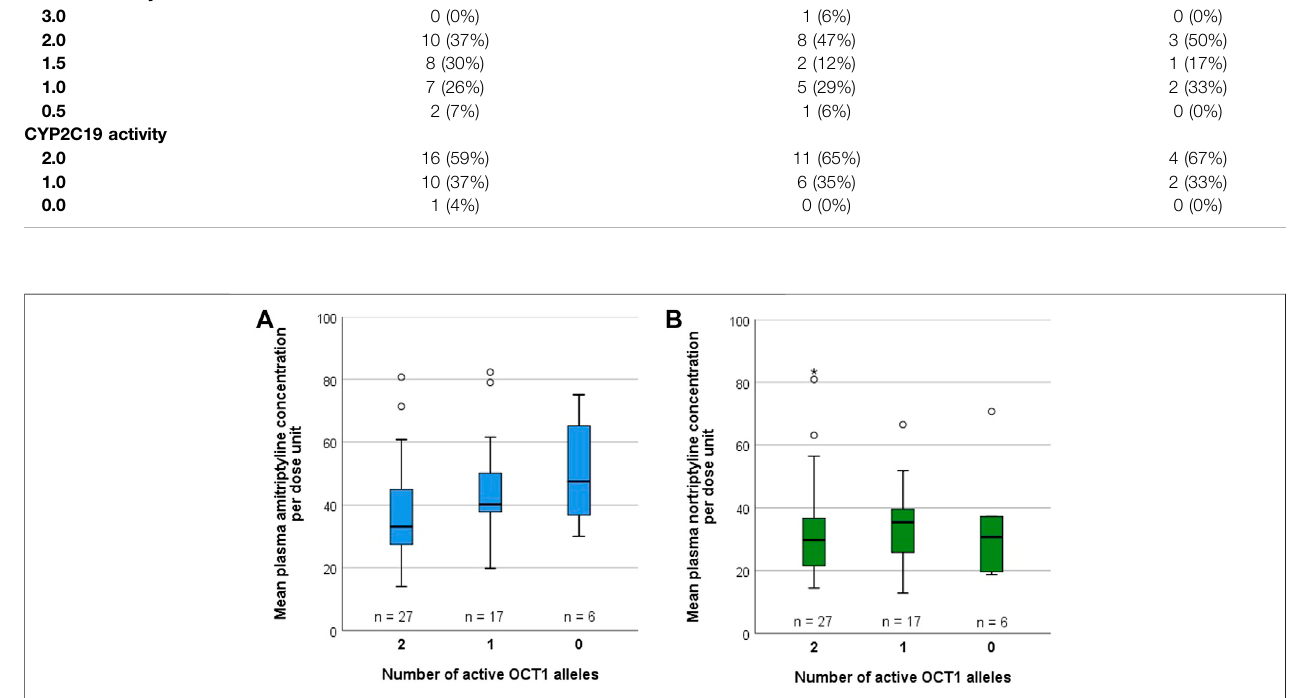
TABLE 6 | Distribution of CYP2D6 and CYP2C19 activity across the study sample of 50 depressive disorder patients, strati fi ed by OCT1 genotype. CYP2D6 activity 3.0